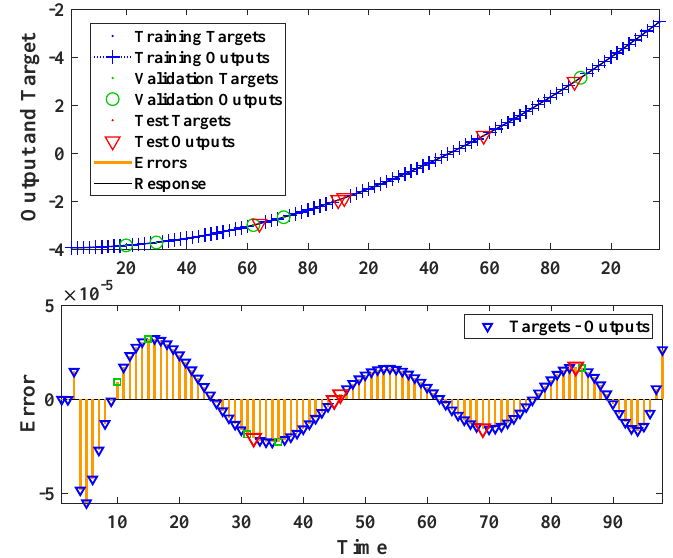
Figure 7. Nonlinear ARX neural network’s time-series response.